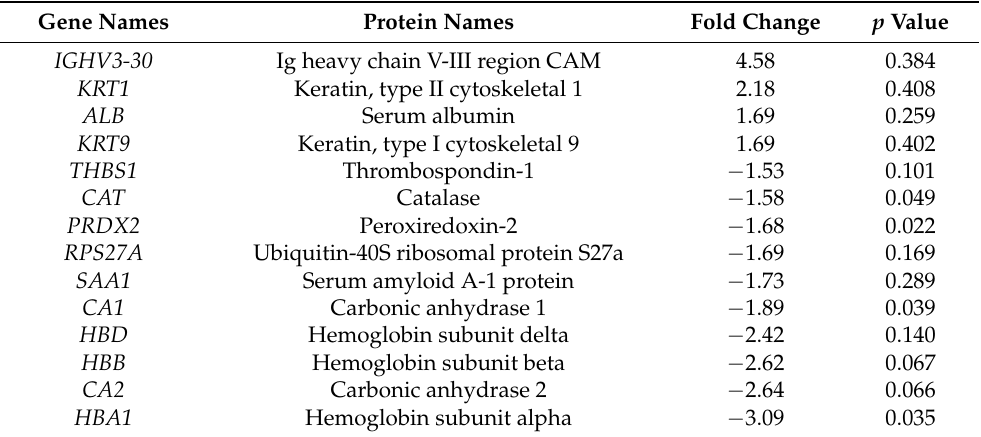
Table 1. List of differentially-expressed proteins identified by isobaric tags for relative and absolute quantitation (iTRAQ) following lymphaticovenous